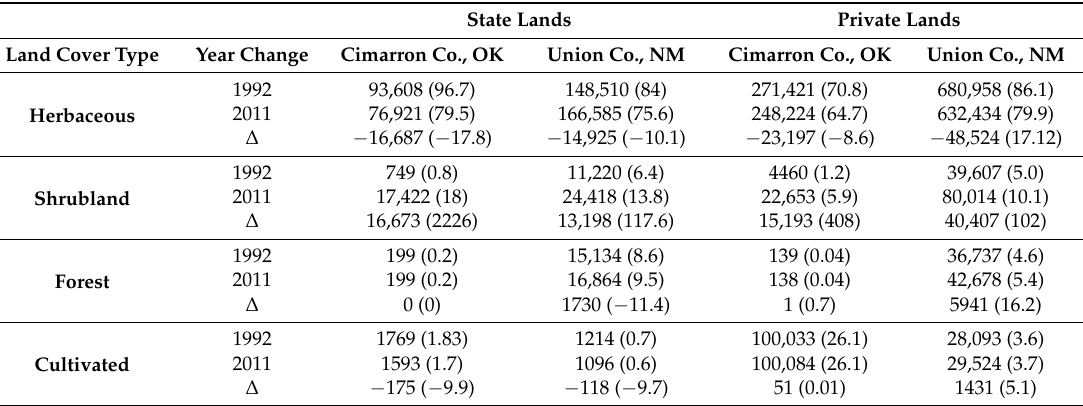
Table 3. Land area by land tenure, land cover type, and year in Cimarron, Co., OK and Union, Co., NM, 1992–2011. All values in ha and